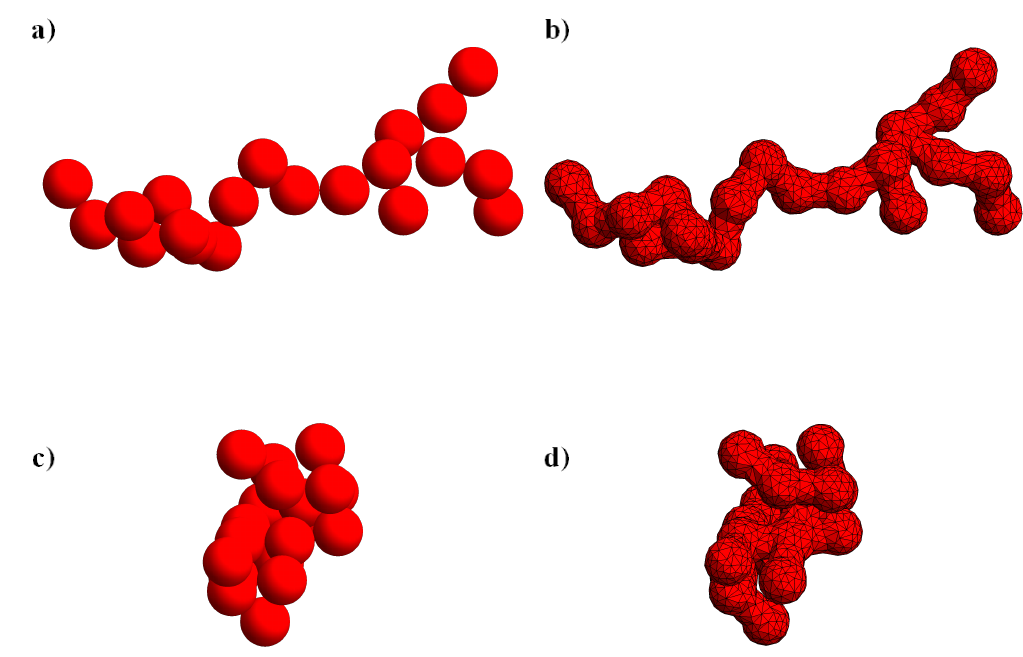
Figure 1. Examples of aggregate shapes obtained from the particle-cluster method for N p = 20, k f = 1.3, and D f = 1.5 ( a ) or D f = 2.5 ( c ). To avoid numerical issues in the region between tangent particles, the centers of the spheres in contact are connected with a set of cylinders with radius 0.732 a . In panels ( b ) and ( d ) the final geometry of the aggregates and the surface mesh are